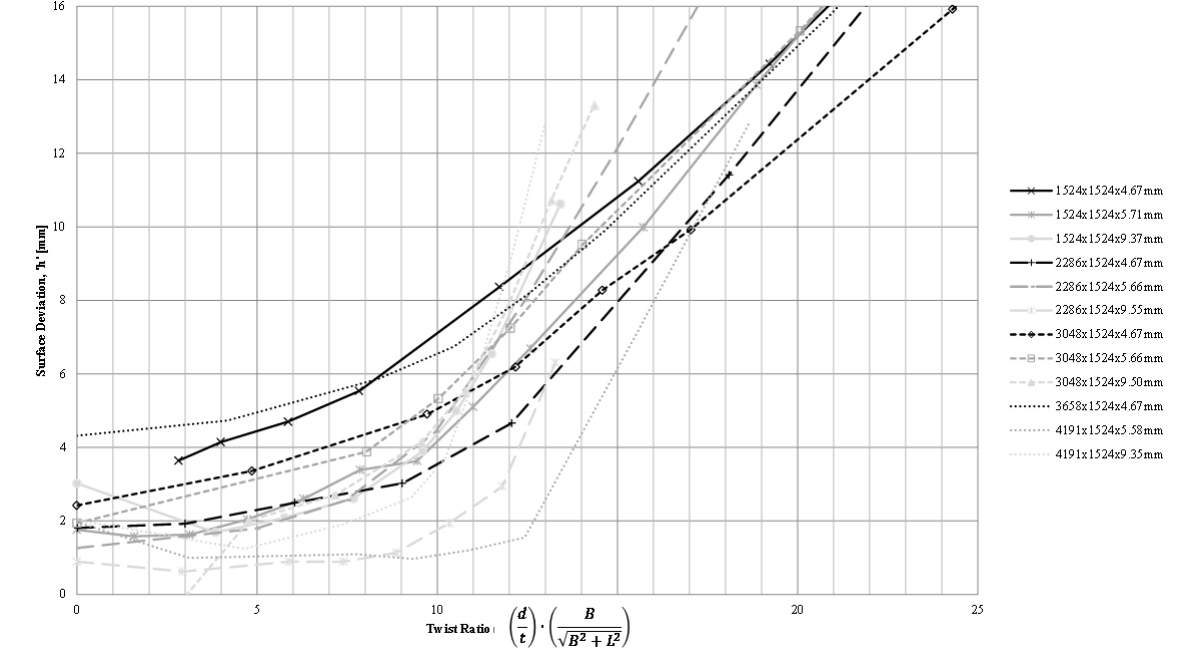
Fig. 8 Physical Test Measurements of Surface Deviation at Increasing Twist, Based on Ratio,